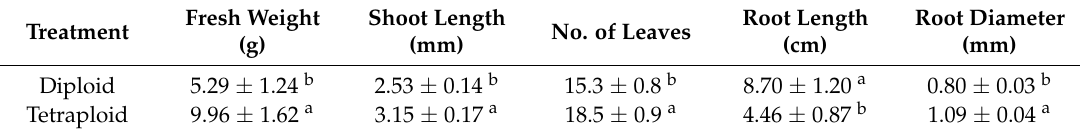
Table 2. Effect of polyploidy in biomass and growth of plantlets in Salvia miltiorrhiza.